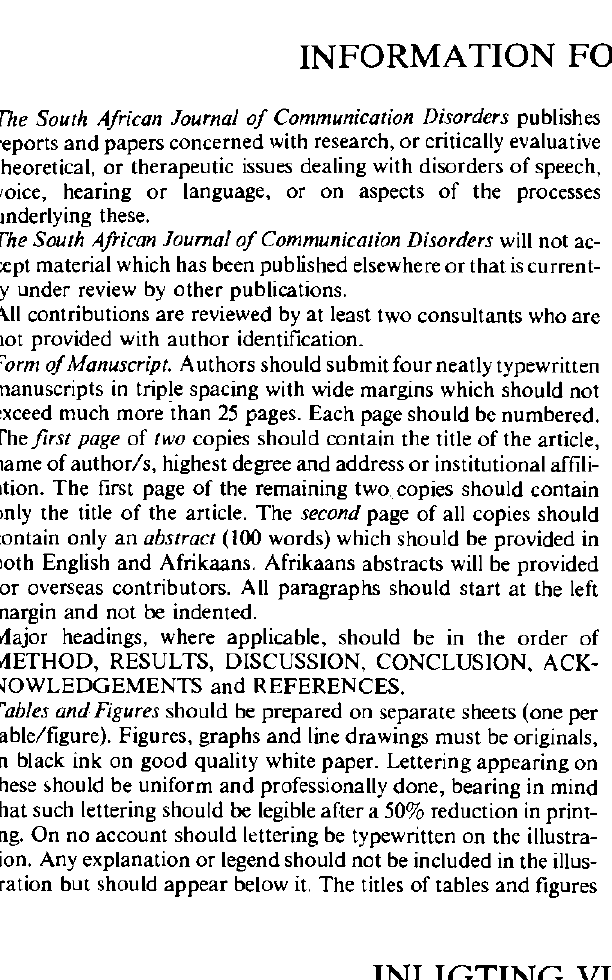
figure onderaan. Tabelle en figure moet in die volgorde waarin hulle verskyn, genommer word (met Arabiese syfers). Die hoeveelheid materiaal in die vorm van tabelle en illustrasies wat toegelaat word, word deur die redakteur bepaal (gewoonlik nie meer as 6 nie). ,